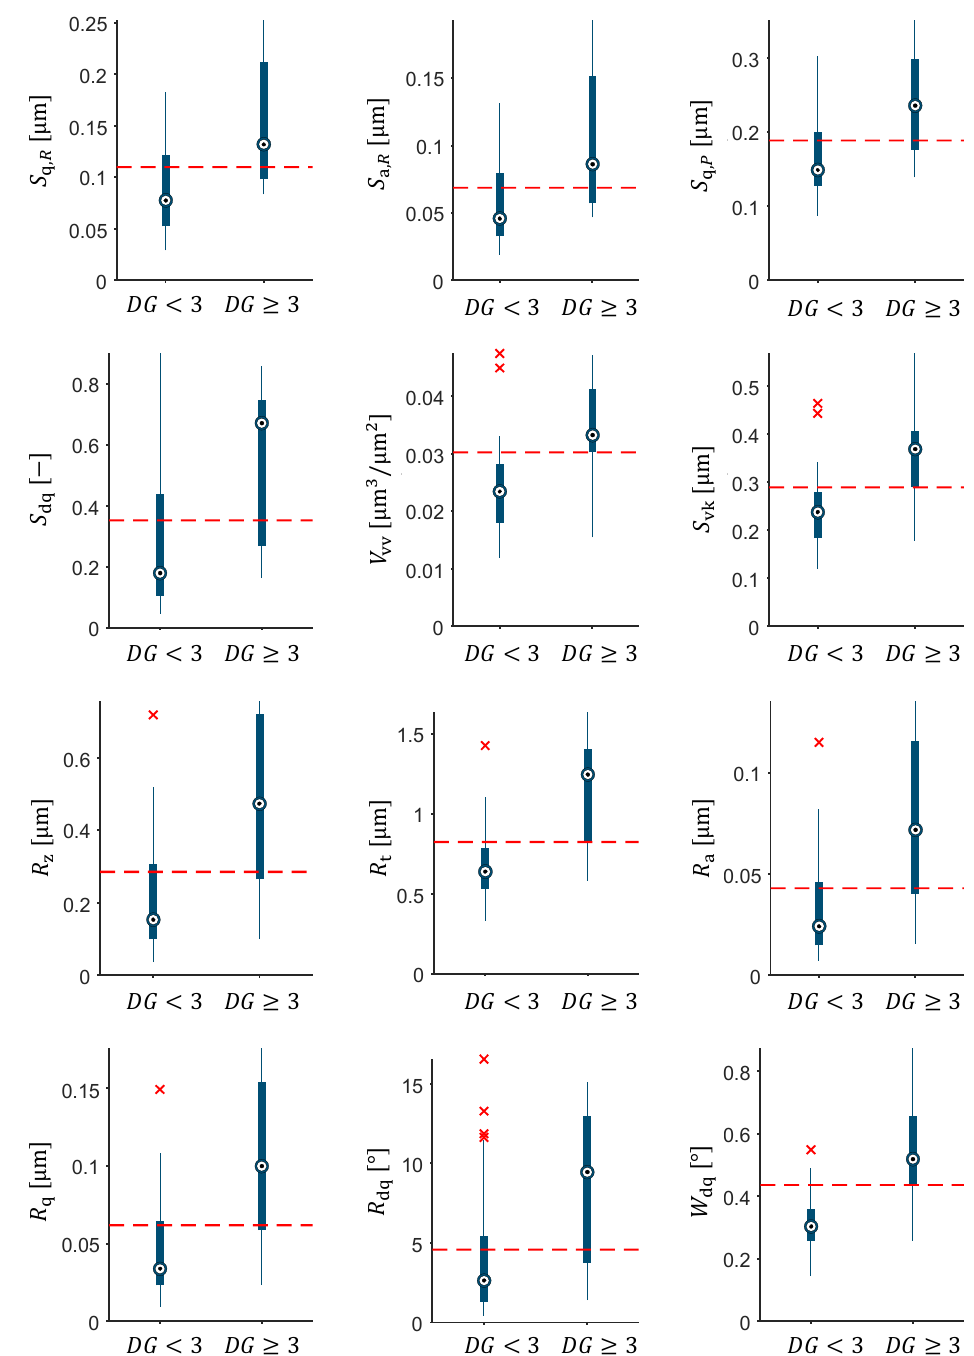
Figure A2. Boxplots of the measured surface properties. The data are separated in two groups for data points with and without corrugations. The red line is the critical value, above which corrugations are likely.